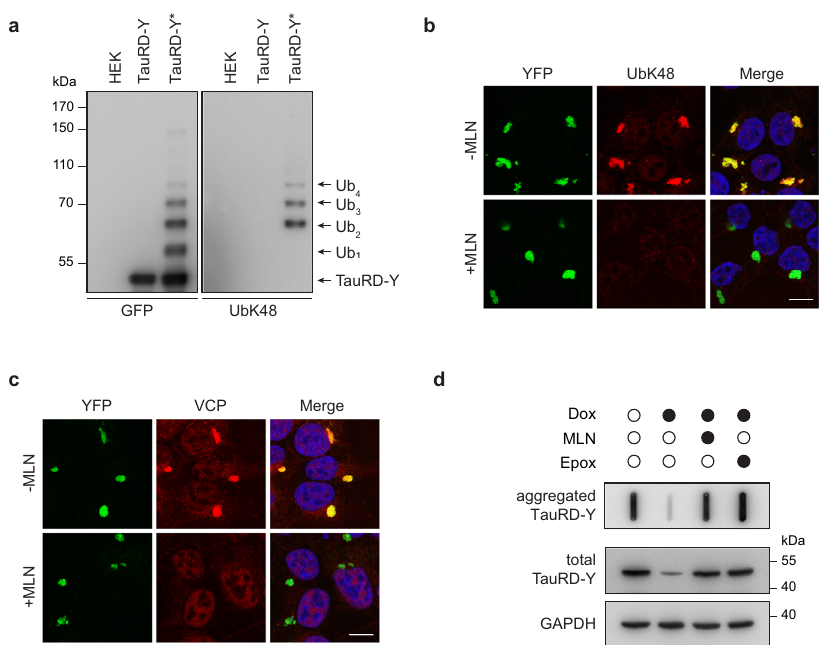
Fig. 4 | Ubiquitination is necessary for VCP recruitment and disaggregation. a ImmunoprecipitationofTauRD-YfromlysatesofcontrolHEKcells,TauRD-Y,and TauRD-Y* cells in the presence of 0.1% SDS using anti-GFP beads. Eluates were analyzed byimmunoblotting withantibodies against GFPand K48-linkedubiquitin chains (UbK48). TheTauRD-Y band shows theunmodi fi ed protein and arrowheads point at increments in ubiquitin conjugation (Ub 1 -Ub 4 ). Representative blots from two independent experiments are shown. b Inhibition of ubiquitylation of TauRD inclusions. TauRD-Y* cells were treated for 12h with MLN7243 (MLN; 0.5 µ M) fol- lowed by immuno fl uorescence analysis with a UbK48 antibody (red).